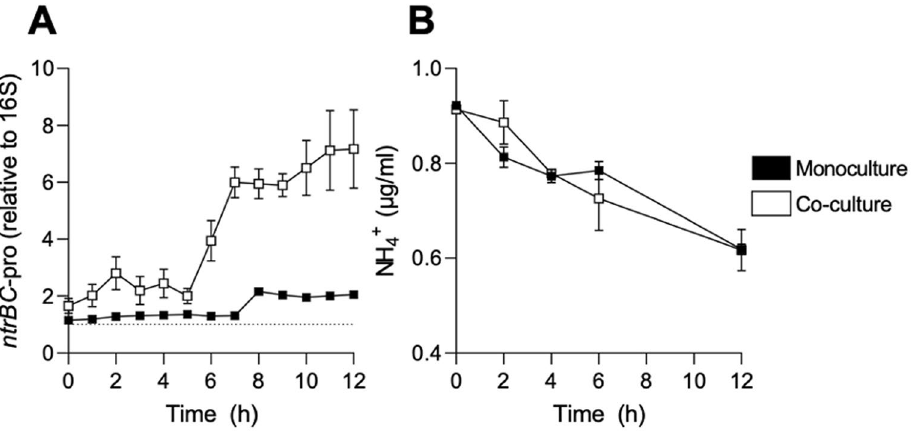
Figure 1. Induction of P. aeruginosa LESB58 ntrBC promoter activity ( ntrBC -pro) during co-culture with S. aureus . ( A ) P. aeruginosa LESB58 was seeded in the absence (shown as monoculture in black) or presence (shown as co-culture in white) of S. aureus USA300 LAC at a total bacterial density of ~ 5 × 10 5 CFU/ml